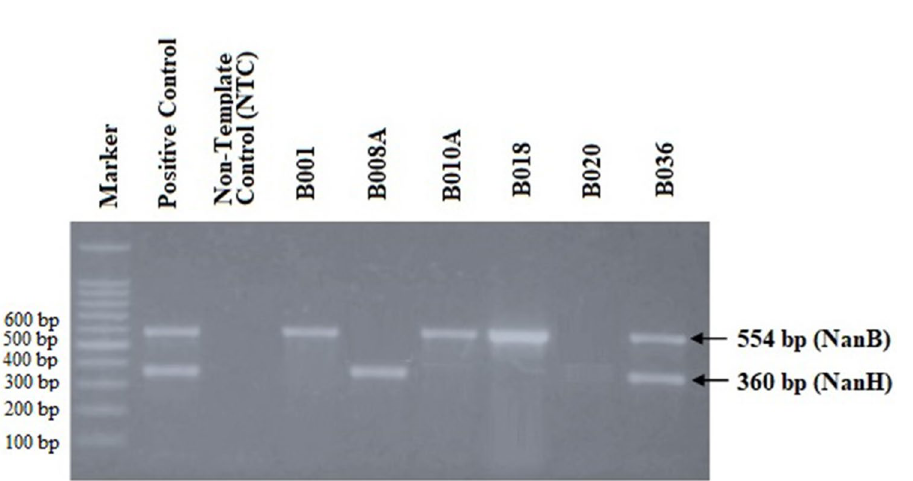
Figure 4. The detection results of NanB and NanH sialidase genes from six isolates confirmed as Pasteurella multocida type A. NanB is indicated by the 554 bp, while NanH in the 360